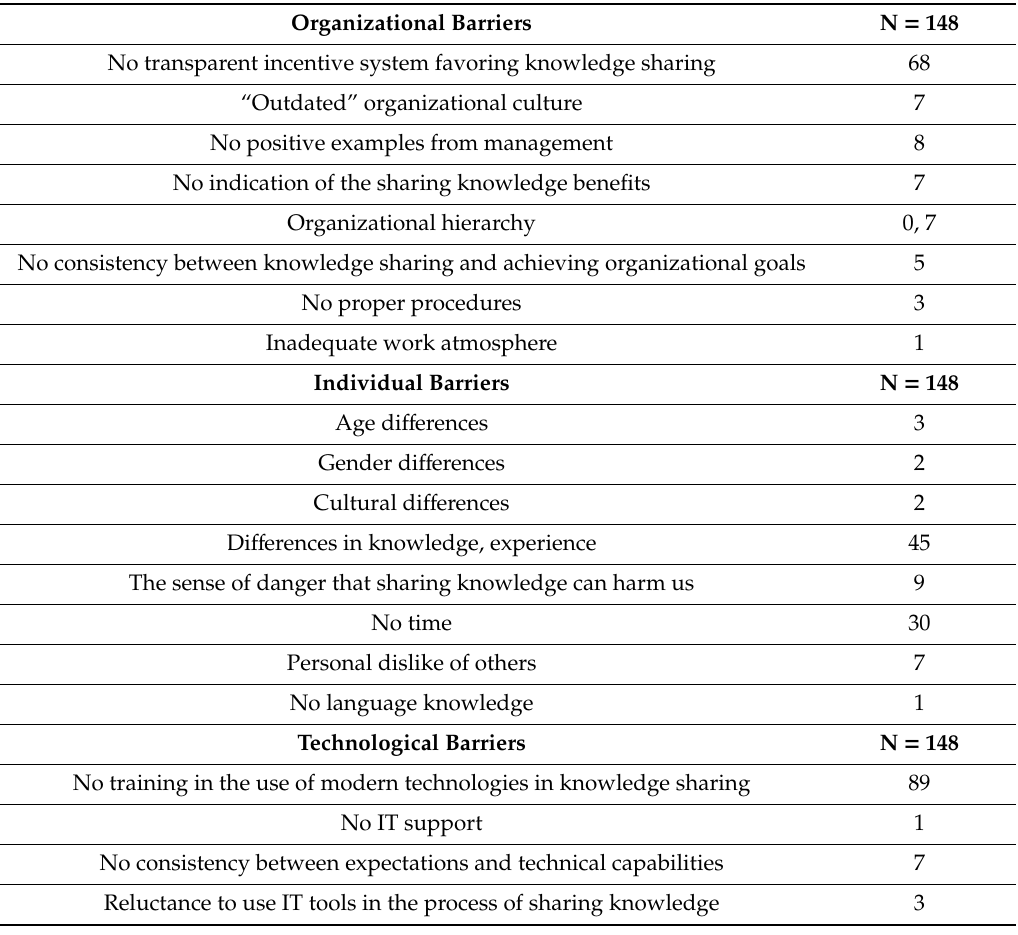
Table 1. Barriers to knowledge sharing according to respondents